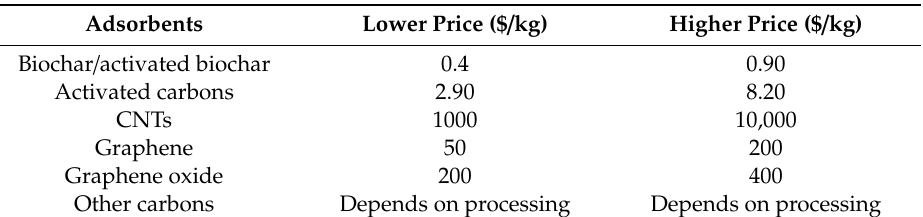
Table 5. Rough prices of di ff erent carbon-based adsorbents [115]. Price varies based on purity, quantity, quality, and type of materials.